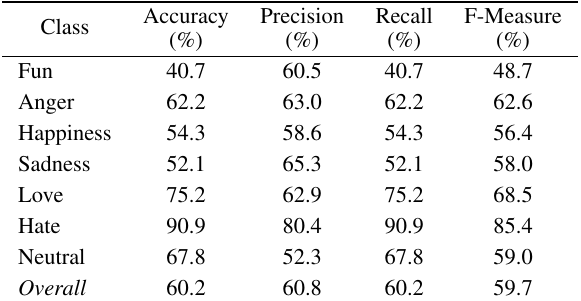
Table 7 Accuracy, Precision, Recall, and F-measure for the classification of tweets of 7 classes.